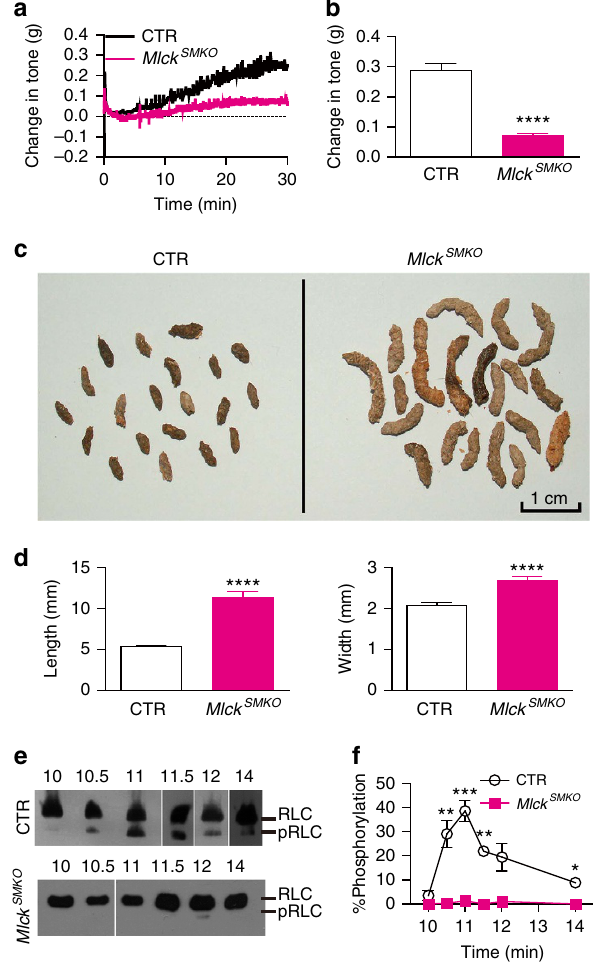
Figure 1 | MLCK and RLC phosphorylation are required for the basal tone in IAS. ( a ) Time courses of changes in force after application of 0.5g tension in CTR and Mlck SMKO mice. ( b ) Summarized data showing much smaller IAS tone in Mlck SMKO mice than in control (mean ± s.e.m., CTR n ¼ 7, Mlck SMKO n ¼ 5, **** P o 0.0001 by two-tailed Student’s t -test ). ( c ) Faeces from CTR mice and Mlck SMKO mice after 20 days of tamoxifen treatment. ( d ) The length (left) and width (right) of faeces were increased in Mlck SMKO mice compared with the controls. Bars represent mean ± s.e.m., n ¼ 20, **** P o 0.0001 by two-tailed Student’s t -test. ( e ) Examples of RLC phosphorylation during the process of spontaneous tone generation in IAS from CTR and Mlck SMKO mice. ( f ) Quantification of p-RLC during basal tone generation in CTR and Mlck SMKO IAS. Bars represent mean ± s.e.m., n ¼ 3, * P o 0.05, ** P o 0.01, *** P o 0.001 by two-tailed Student’s t